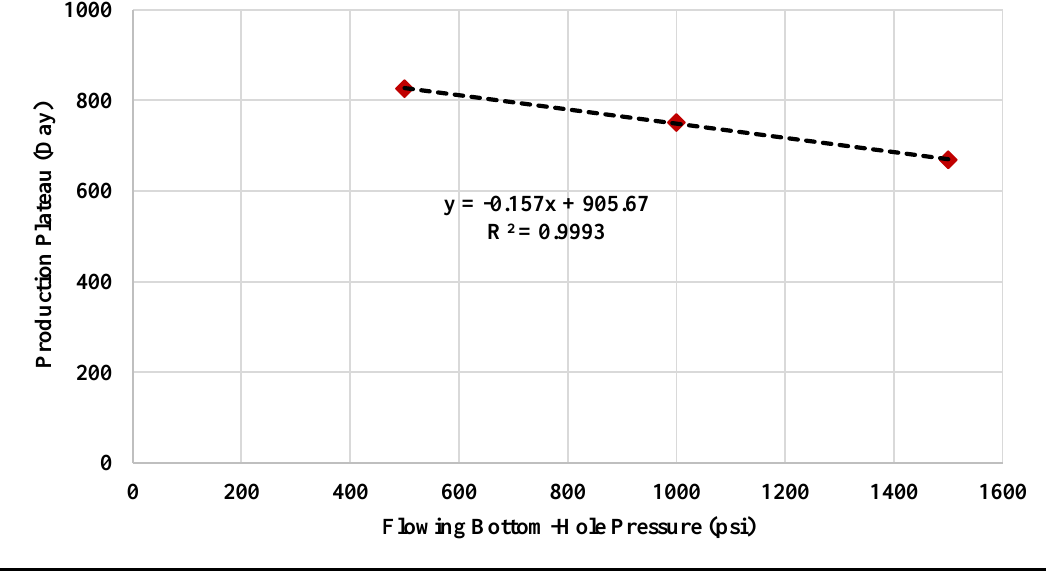
Figure 14. Duration of production plateau plotted against flowing bottom-hole pressure.